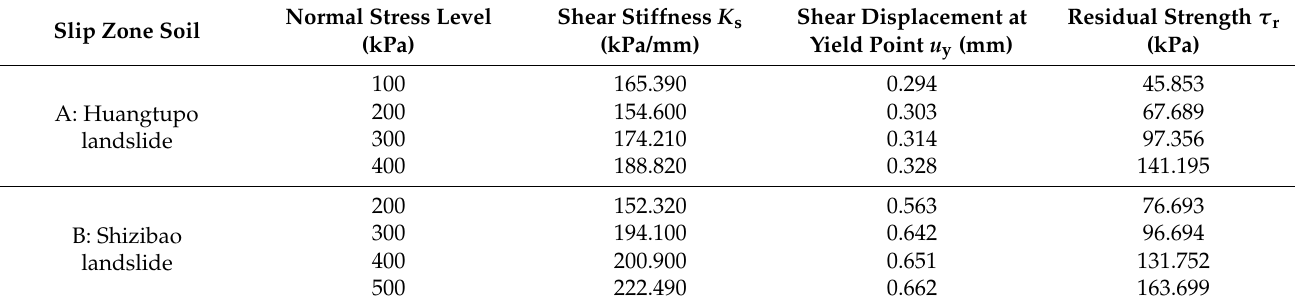
Table 1. Parameters of ring shear test of the slip zone